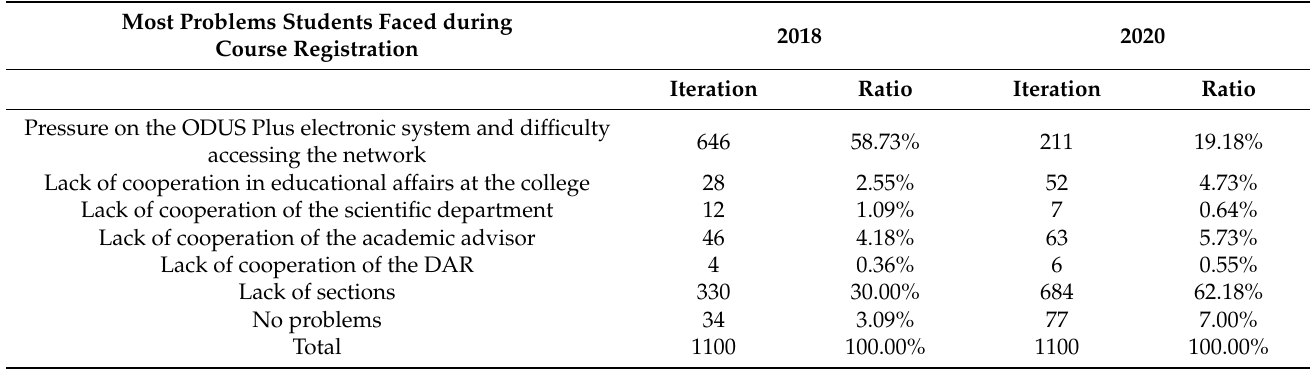
Table 7. Distribution of student numbers by problems they encountered during the registration